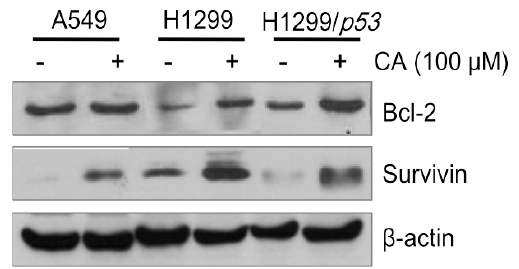
Figure 4. The modulations of pro-survival proteins by CA. The non-small cell lung cancer (NSCLC) cell lines A549, H1299 and H1299 transfected with functional p53 were treated with 100 µM CA for 24 h, respectively. Afterwards, the protein levels of pro-survival Bcl-2 and survivin were determined using Western blot assay. Beta-actin was used as an internal